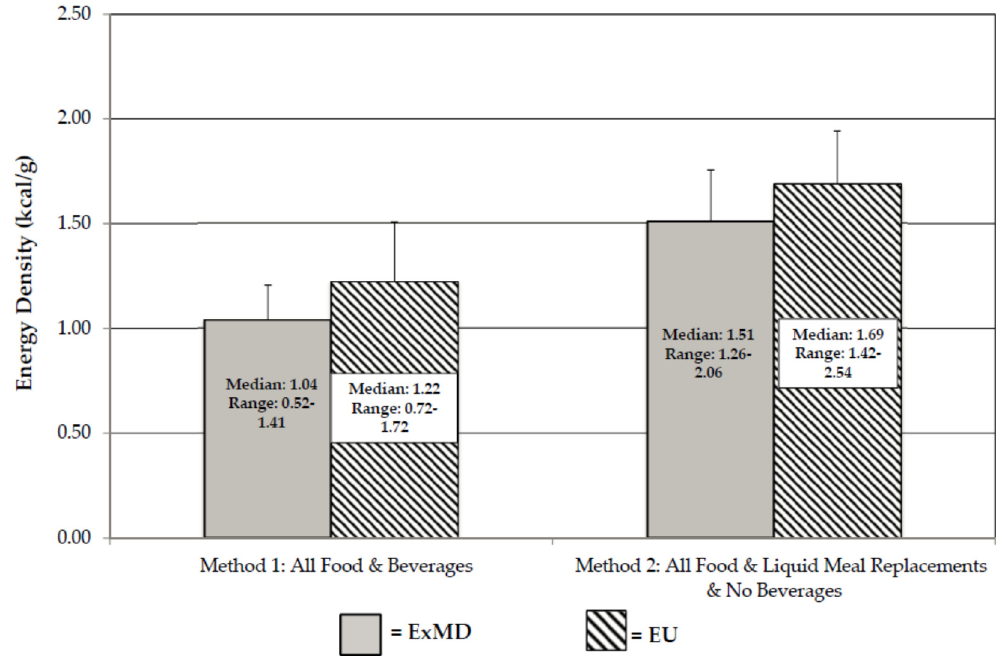
Figure 1. Energy Density of Exercise-Associated Menstrual Dysfunction (ExMD) and Eumenorrheic (EU) Active Women. Note: Adjusted p-values: Method 1 p = 0.285; Method 2 p = 0.098.